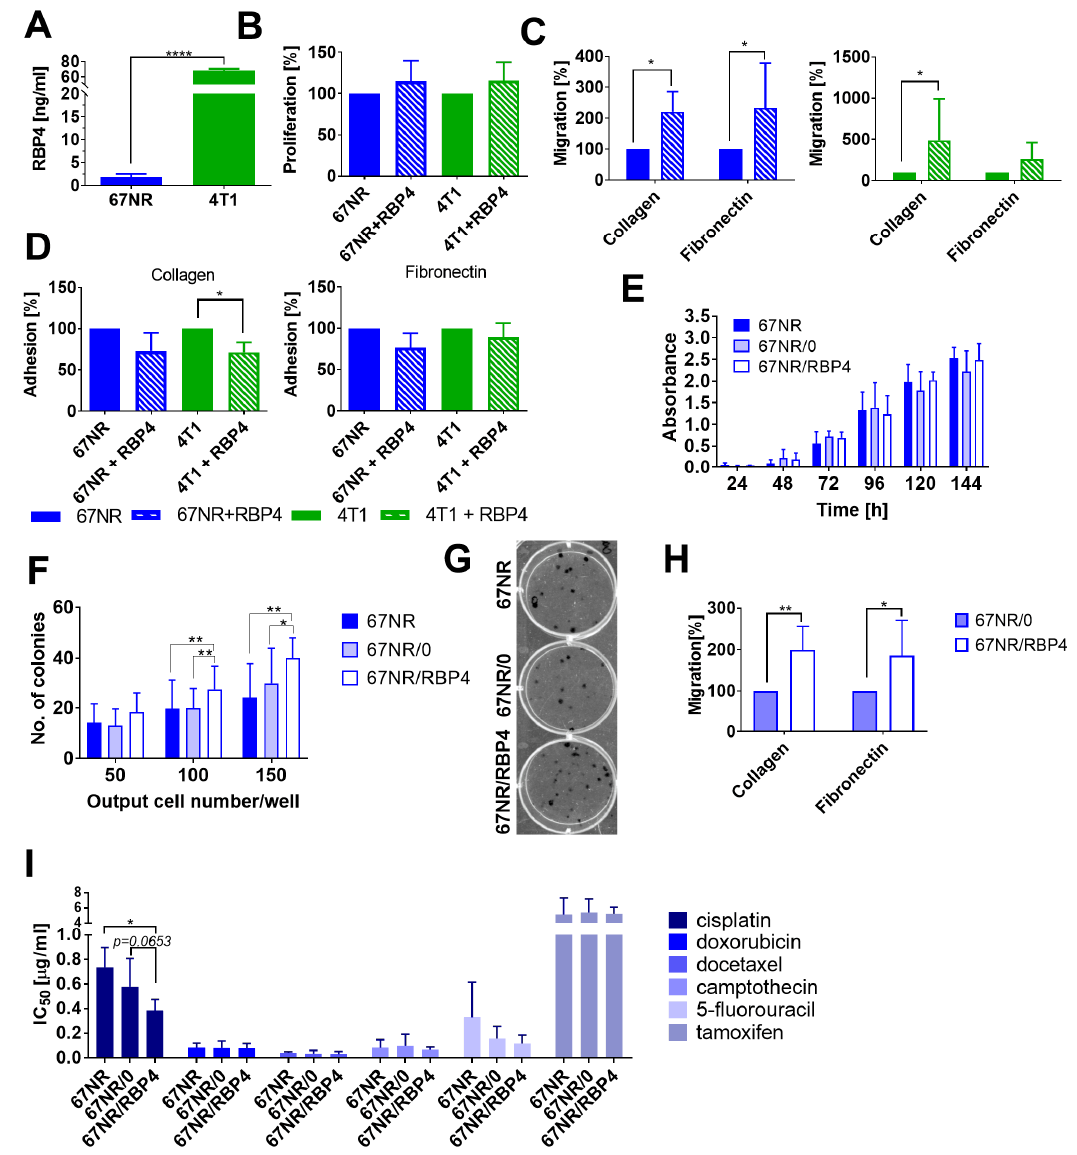
Figure 6. In vitro characteristics of the e ff ect of RBP4 on 4T1 and 67NR mouse mammary gland cancer. ( A ) Comparison of RBP4 level in 4T1 and 67NR cell lysates using ELISA. ( B – D ) The e ff ect of 24 h incubation with 200 ng / mL of RBP4 on ( B ) cell proliferation ( N = 4), ( C ) migration ( N = 6), and ( D ) adhesion ( N = 3). ( E ) The proliferation of wild-type and transduced 67NR cells measured between 24 and 144 h ( N = 2–6). ( F ) Number of colonies formed 14 days after seeding three di ff erent numbers of wild-type and transduced 67NR cells ( N = 3 for 150 cells; N = 8 for 50 and 100 cells / well). ( G ) Representative image of colonies formed after seeding of 100 cells / well. ( H ) Migration of 67NR / 0 and 67NR / RBP4 cell lines through collagen and fibronectin ( N = 4–6). ( I ) The sensitivity of 67NR / RBP4 cells to commonly used anticancer drugs ( N = 3–7). Statistical analysis: Tukey’s multiple comparison test or unpaired t test; ( I ) Dunnett’s multiple comparison test. * p < 0.05, ** p < 0.01, **** p <